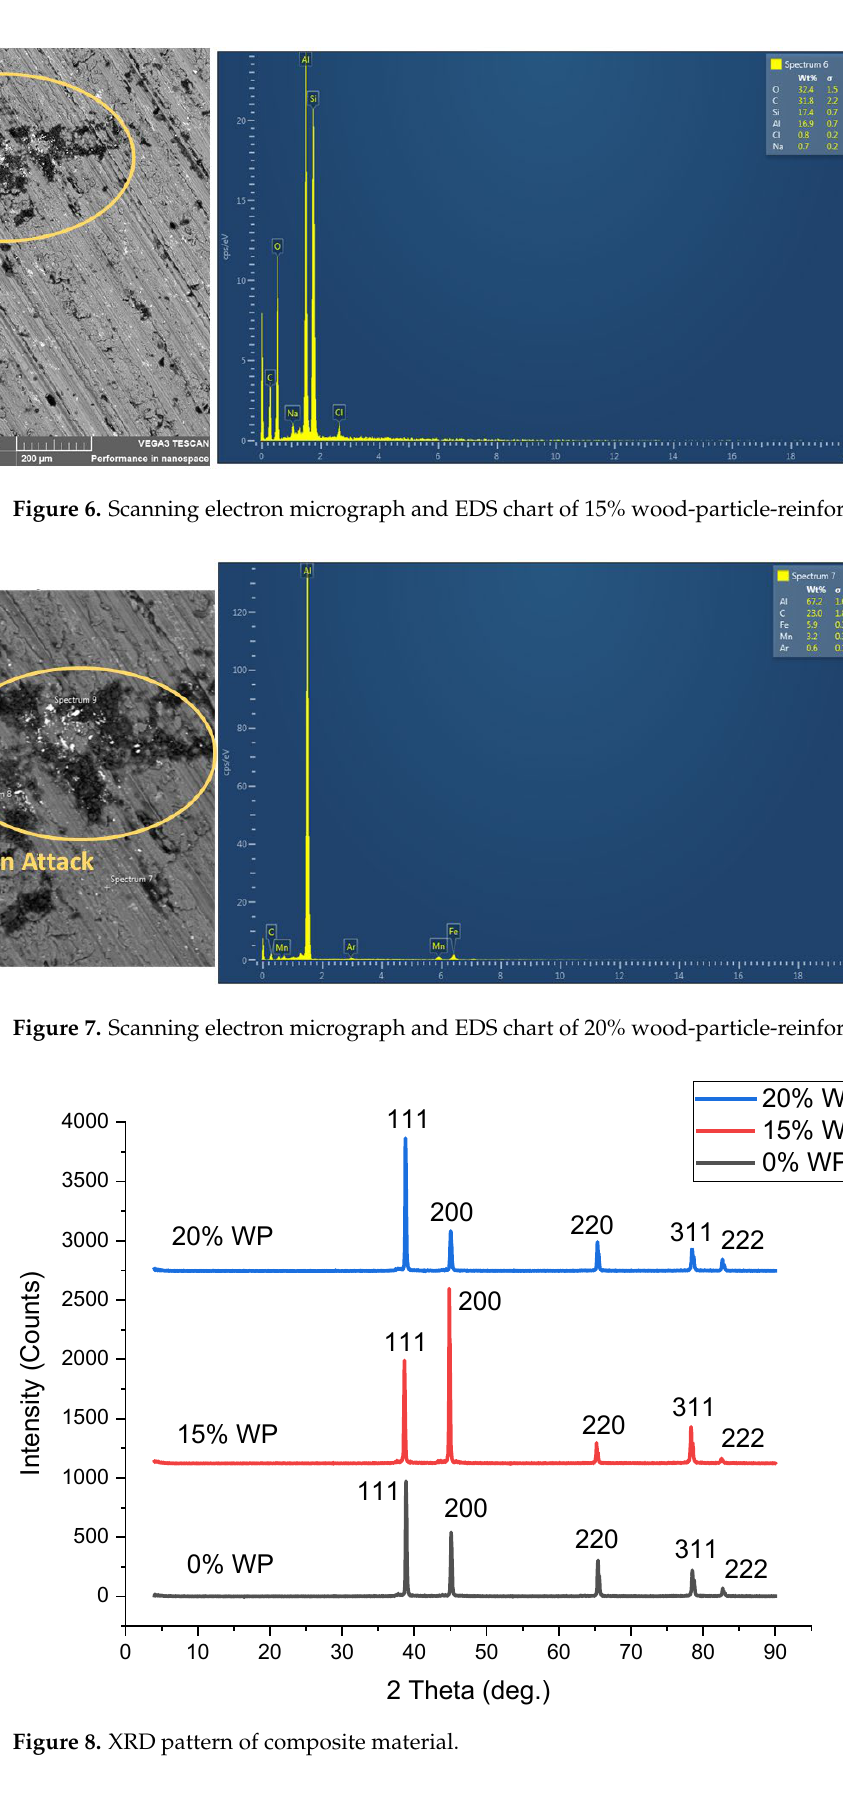
Figure 5. Scanning electron micrograph and EDS chart of 0% wood-particle-reinforced composite.